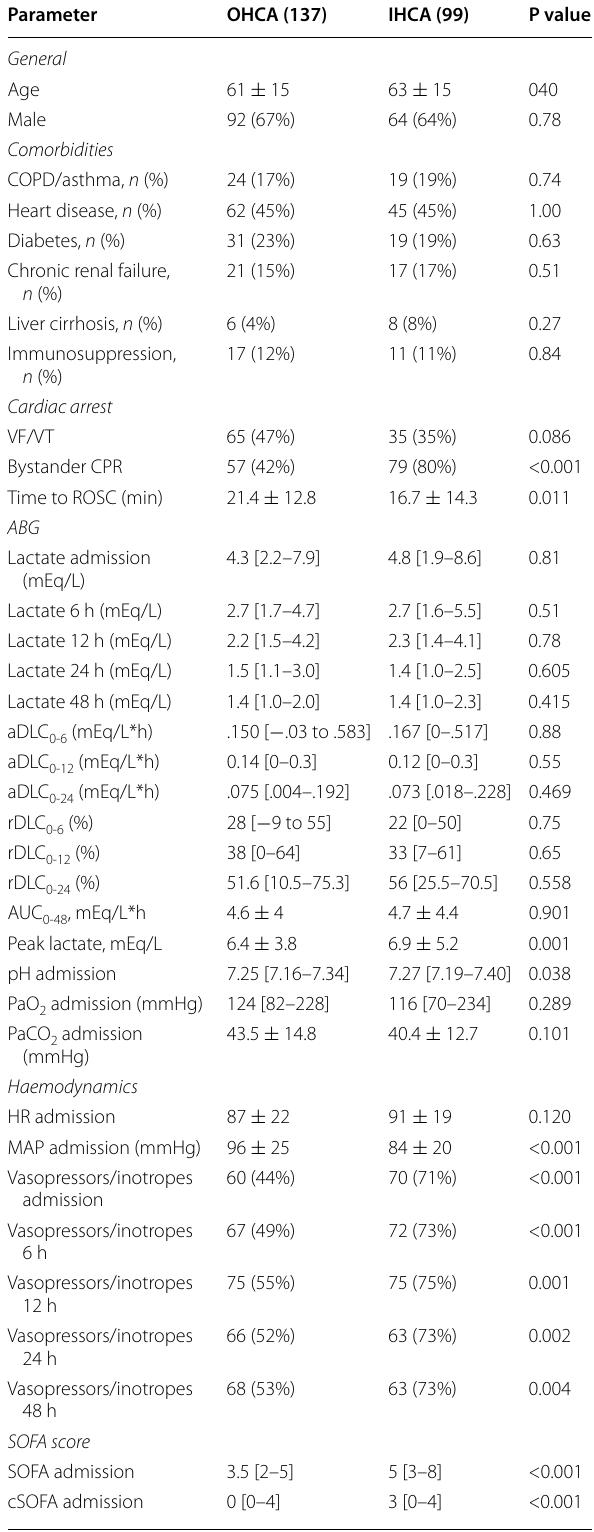
Table 3 Characteristics of patients according to arrest location (out of hospital [OHCA] vs. in hospital